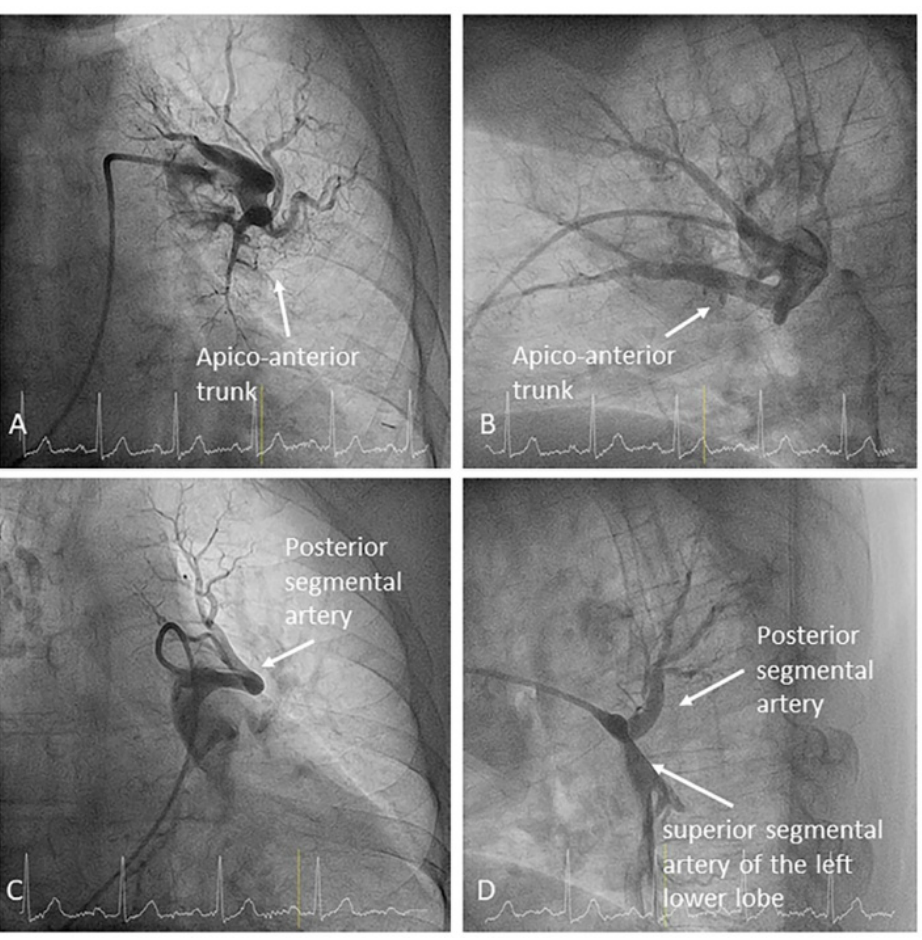
Figure 8. Left upper lobe branches. The posterior segmental artery (A2) originates in the superior